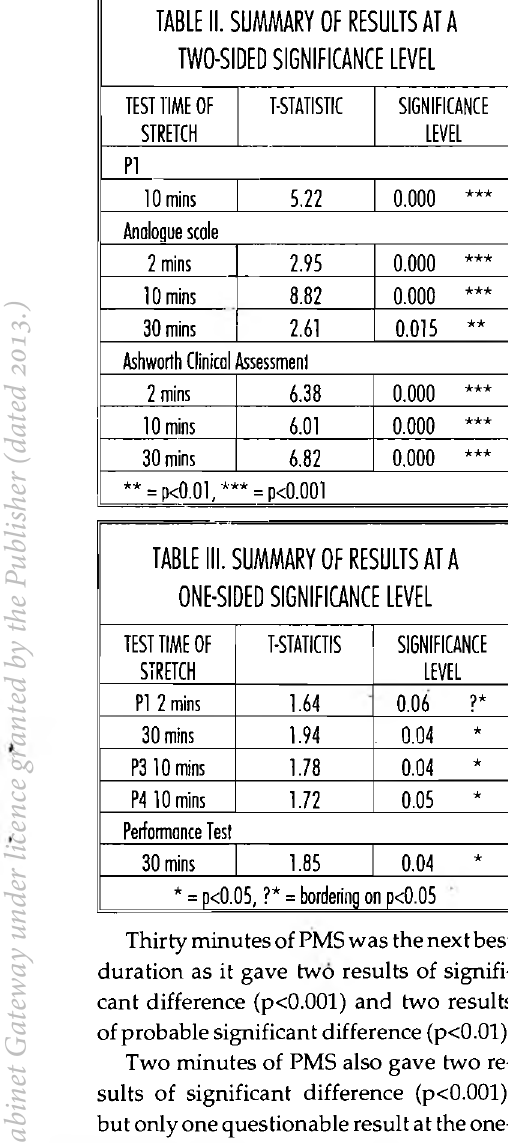
TABLE II. SUMMARY OF RESULTS AT A TWO-SIDED SIGNIFICANCE LEVEL